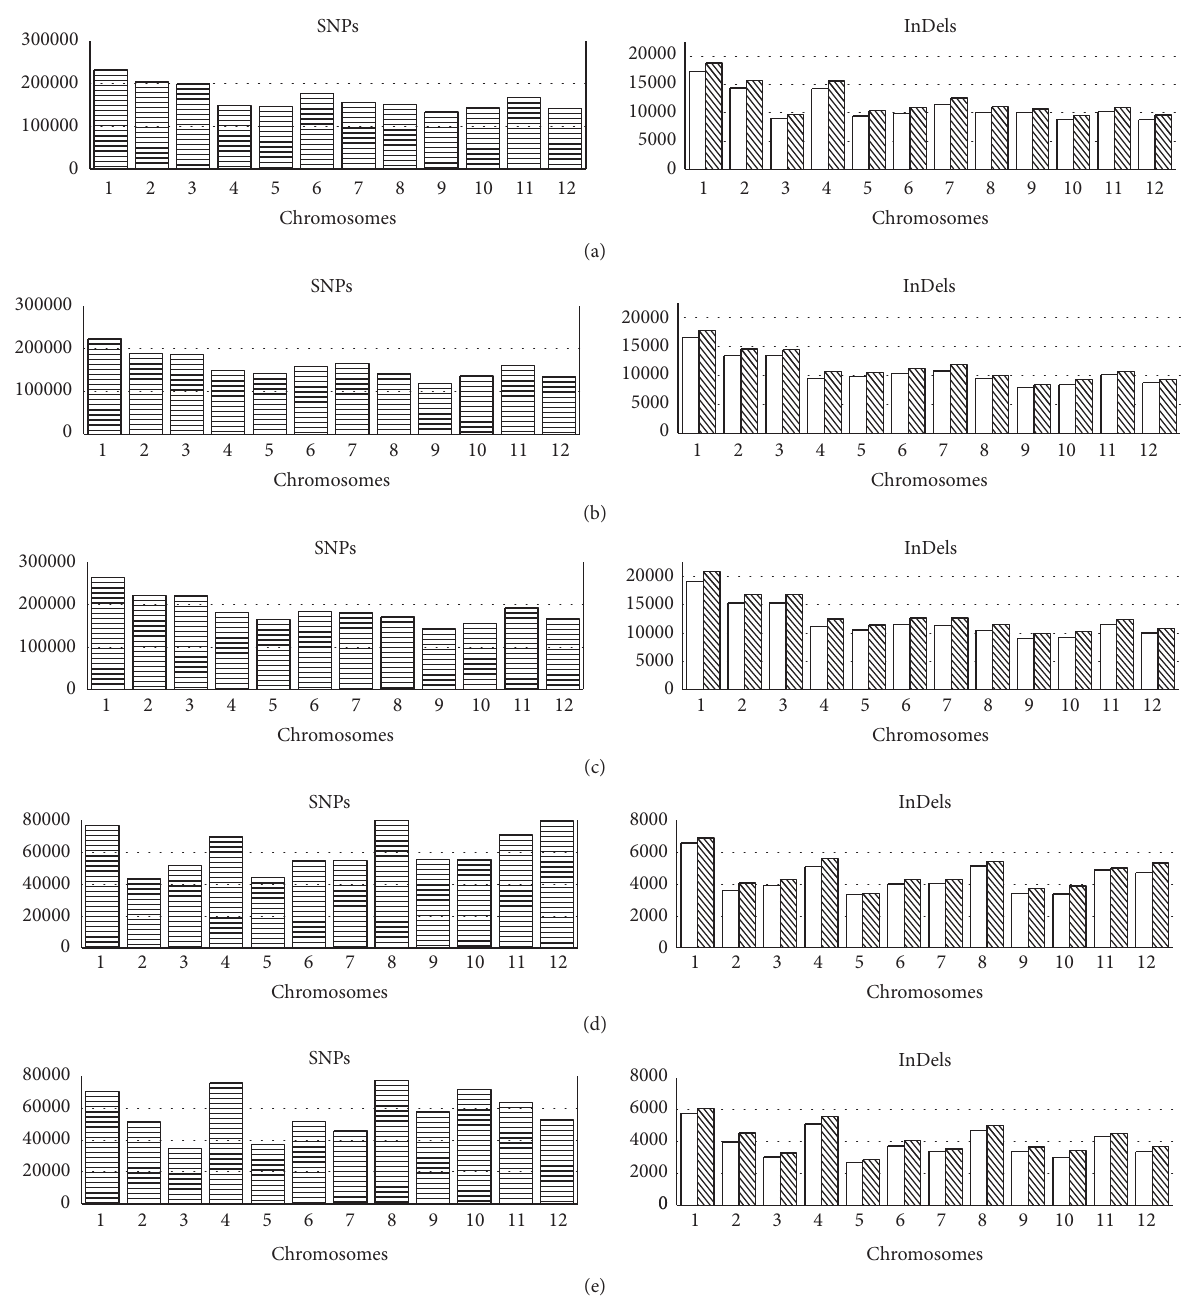
Figure 1: The number of SNPs and InDels on each chromosome in five landraces in comparison with the Nipponbare reference. The 𝑥 - axis represents the chromosomes. The 𝑦 -axis represents the number of SNPs (horizontal-line bars), insertions (white bars), and deletions (downward-diagonal bars). The five rice lines were (a) indica 12, (b) indica 13, (c) indica 15, (d) japonica 11, and (e) japonica 14.